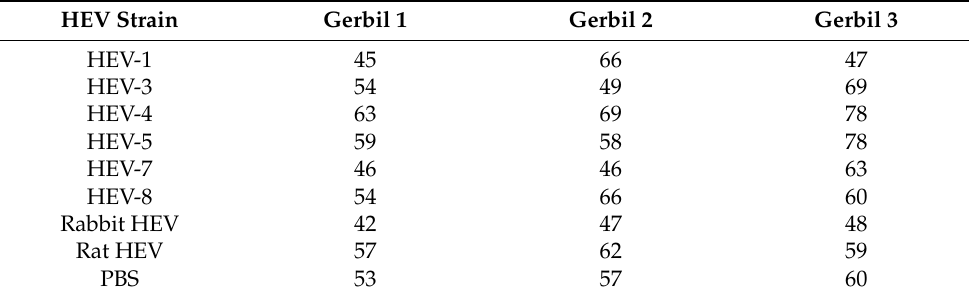
Rabbit HEV 42 47 Rat HEV 57 PBS